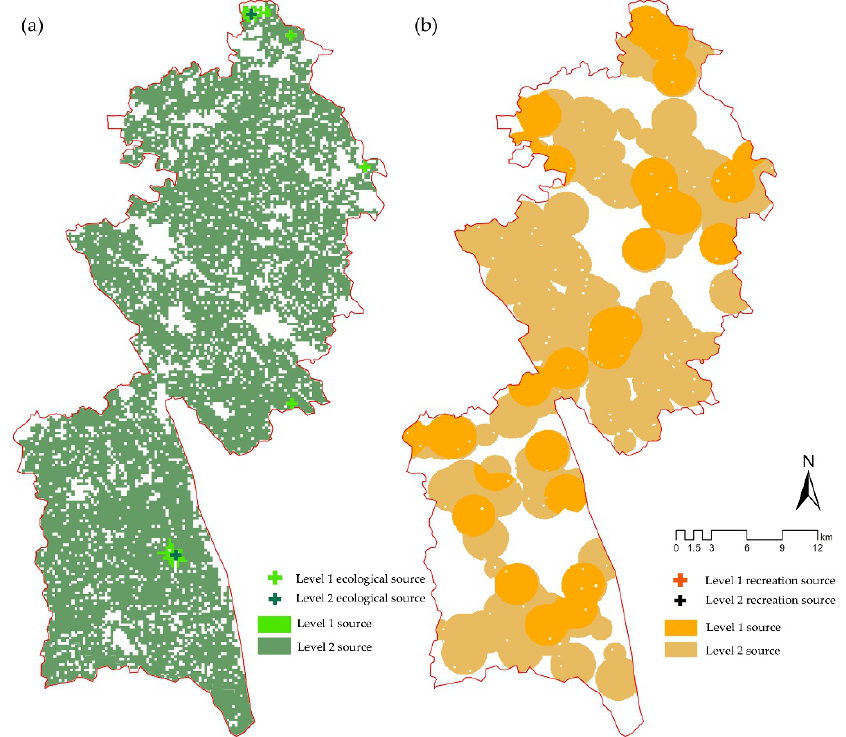
Figure 8. Source distribution: ( a ) determination of the ecological source and ( b ) determination of the recreation source.